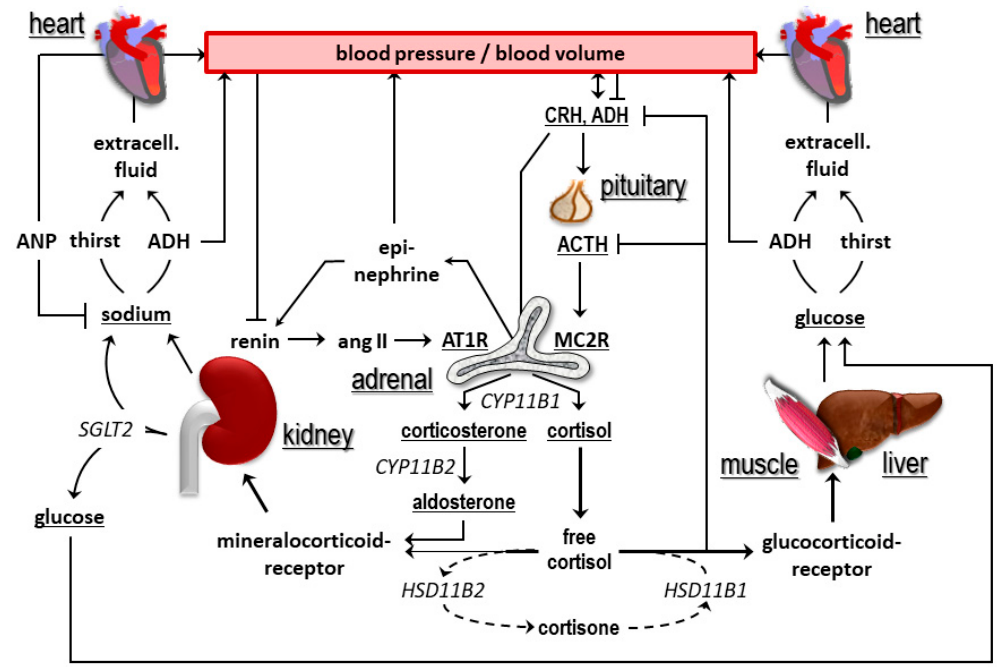
Figure 1. Parallelisms in the regulation of glucose and salt blood concentrations. This figure is a further development of the scheme in [9]. Notably, both glucose and sodium are reclaimed in the kidney through the action of sodium-glucose cotransporters.